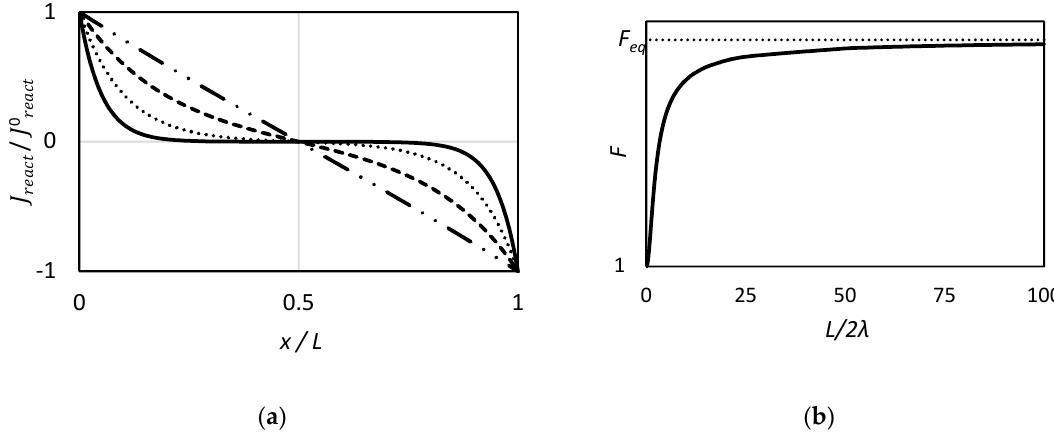
Figure 1. Effect of ratio between membrane thickness ( L ) and characteristic length ( λ ) on the transport in the model of Blumenthal and Katchalsky. ( a ) Size of equilibrium core in the membranes for different λ values (Continuous lines λ = 0.05, dotted lines λ = 0.1, broken lines λ = 0.2, broken dotted lines λ = 1); ( b ) Facilitation factor as function of λ . F eq represents Equation (40).